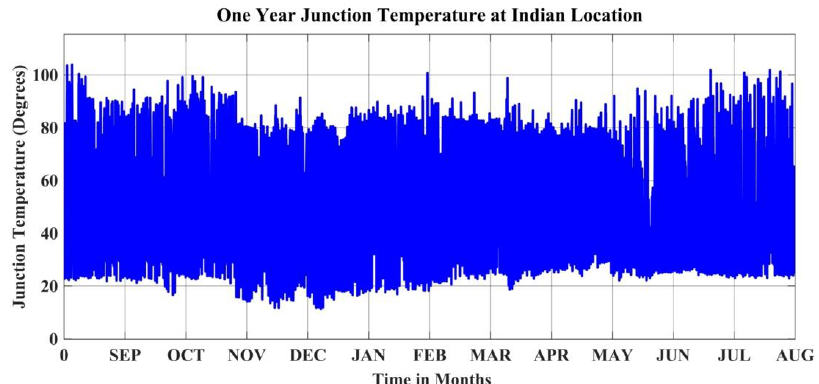
Figure 7. One-year estimated junction temperatures at the location in India.